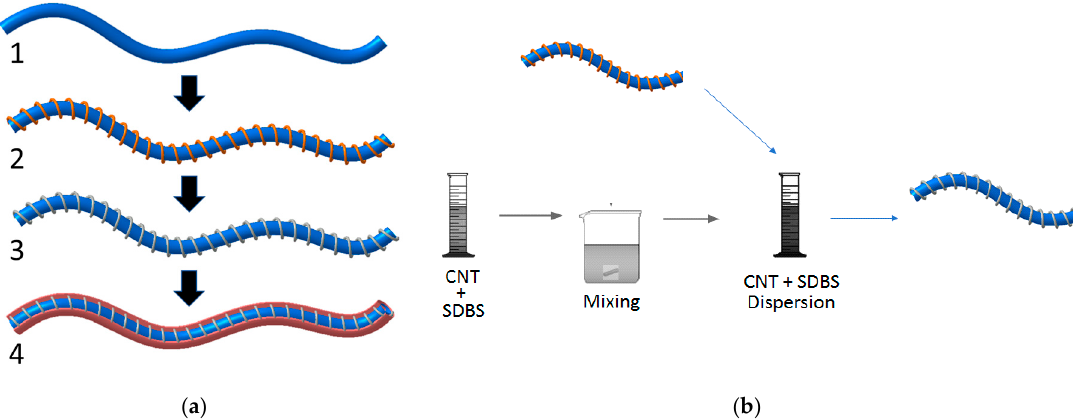
Figure 1. Obtainment of filament based sensor: ( a ) Fiber based sensor synthesis stages: (a.1) Polyurethane core fiber, (a.2) Polyurethane core fiber + Polyester fibers, (a.3) Polyurethane core fiber + Polyester fibers coated with MWCNT (a.4) Polyurethane core fiber + Polyester fibers coated with MWCNT, encased (coated) with Latex; ( b ) Laboratory sequence for solution and coating making.